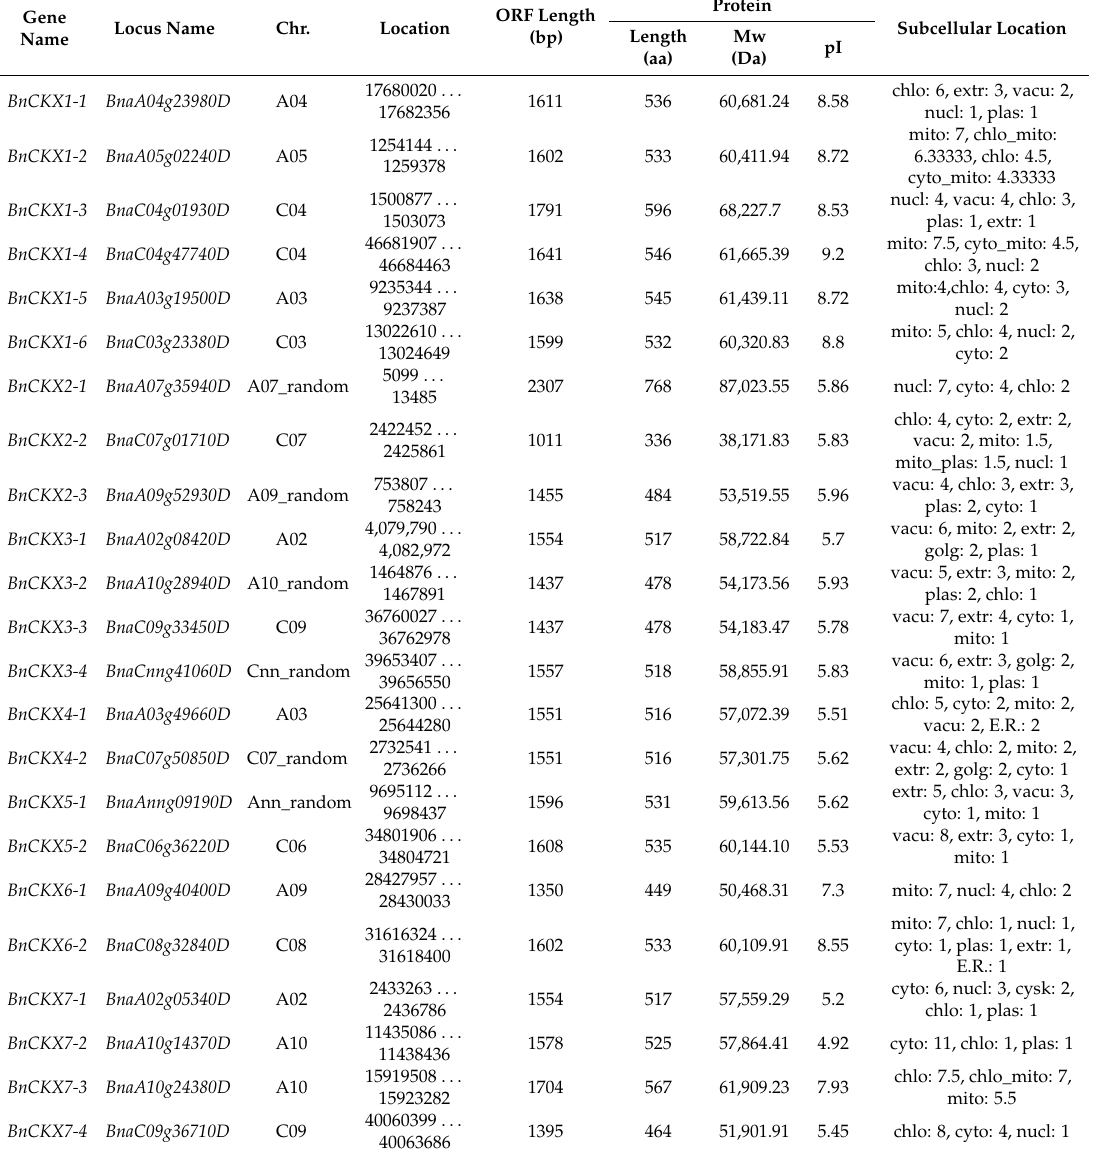
Table 1. Complete list of the 23 BnCKX genes identified in this